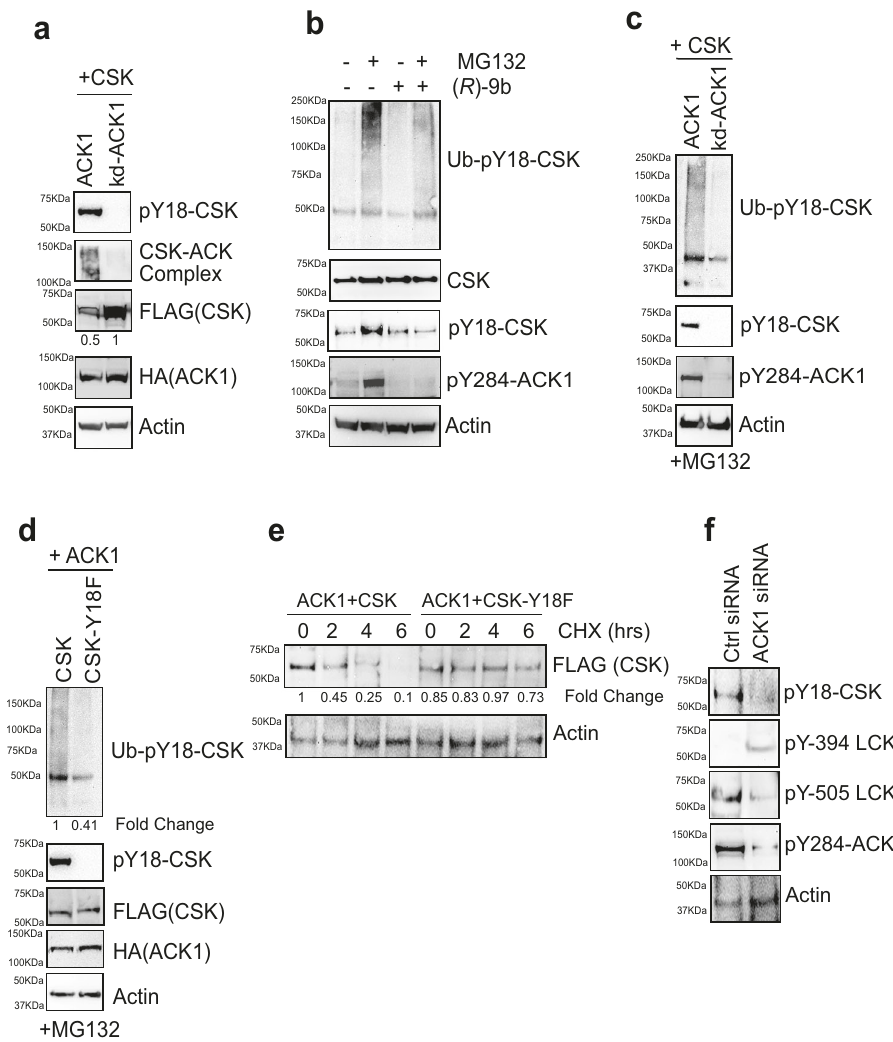
Fig. 3 | ACK1 mediated CSK Y18-phosphorylation regulates its proteasomal turnover. a HEK293T cells were co-transfected with FLAG-tagged CSK and HA- tagged ACK1 or kd-ACK1. Lysates were immunoprecipitated with CSK antibody, followed by immunoblotting with ACK1 antibodies (2nd panel). Upper and lower blots were immunoblotted with indicated antibodies. Fold changes were obtained forindicatedimmunoblotsafternormalizationwithrespectiveactinlevels. b Jurkat cells were treated with DMSO or ( R )- 9b (3 μ M) overnight, followed by treatment with MG132 (25 μ M, 3hr). Lysates were immunoprecipitated with pY18-CSK anti- body, followed by immunoblotting with ubiquitin antibody (top panel). c HEK293T cells were co-transfected with CSK and ACK1 or kd-ACK1. 48hr post transfection, cells were treated with MG132 (25 μ M, 3hr). Lysates were immuno- precipitated with pY18-CSK antibody, followed by immunoblotting with ubiquitin